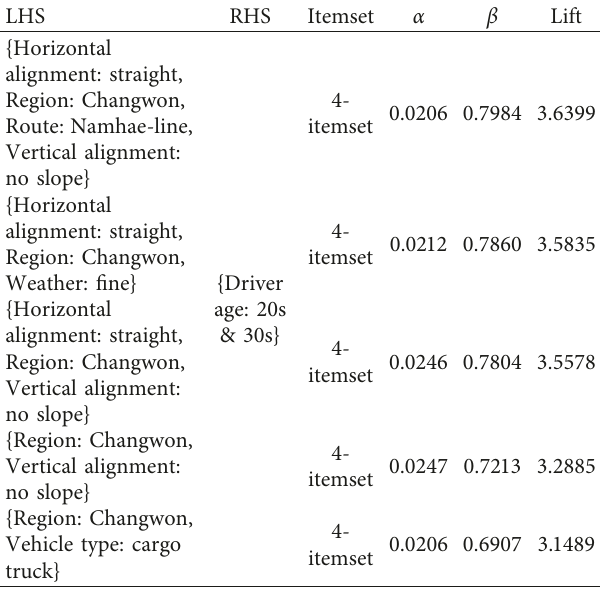
Table 6: Association rules by driver’s age